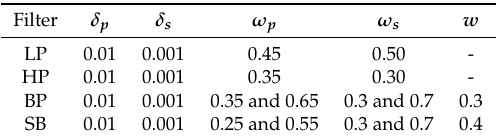
Table 3. Design specifications of Low Pass (LP), High Pass (HP), Band Pass (BP) and Stop Band (SB)